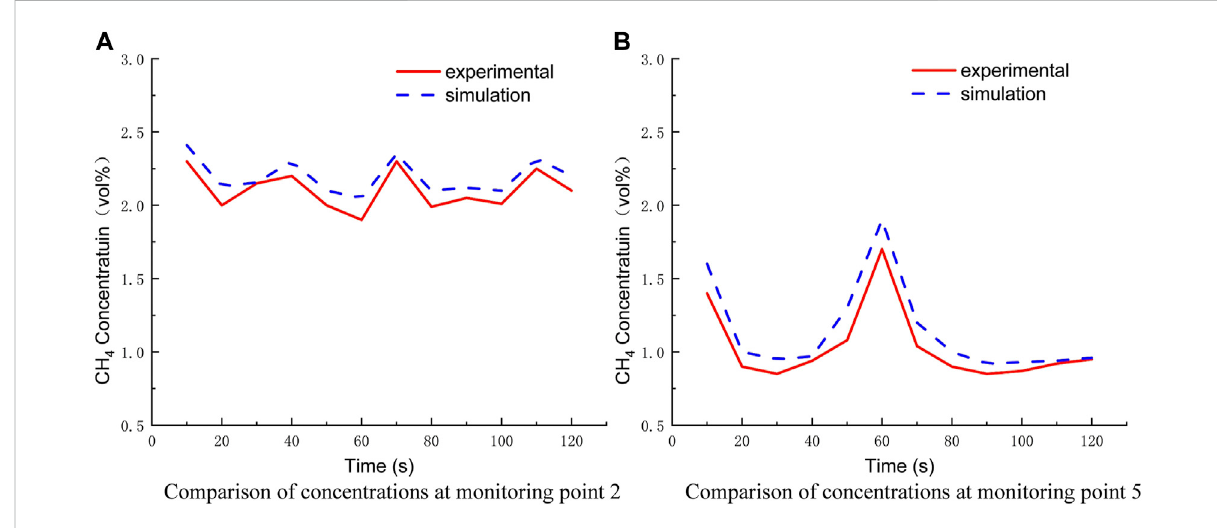
FIGURE 3 Comparison between numerical simulation and experimental results. (A) Comparison of concentrations at monitoring point 2. (B) Comparison of concentrations at monitoring point 5.